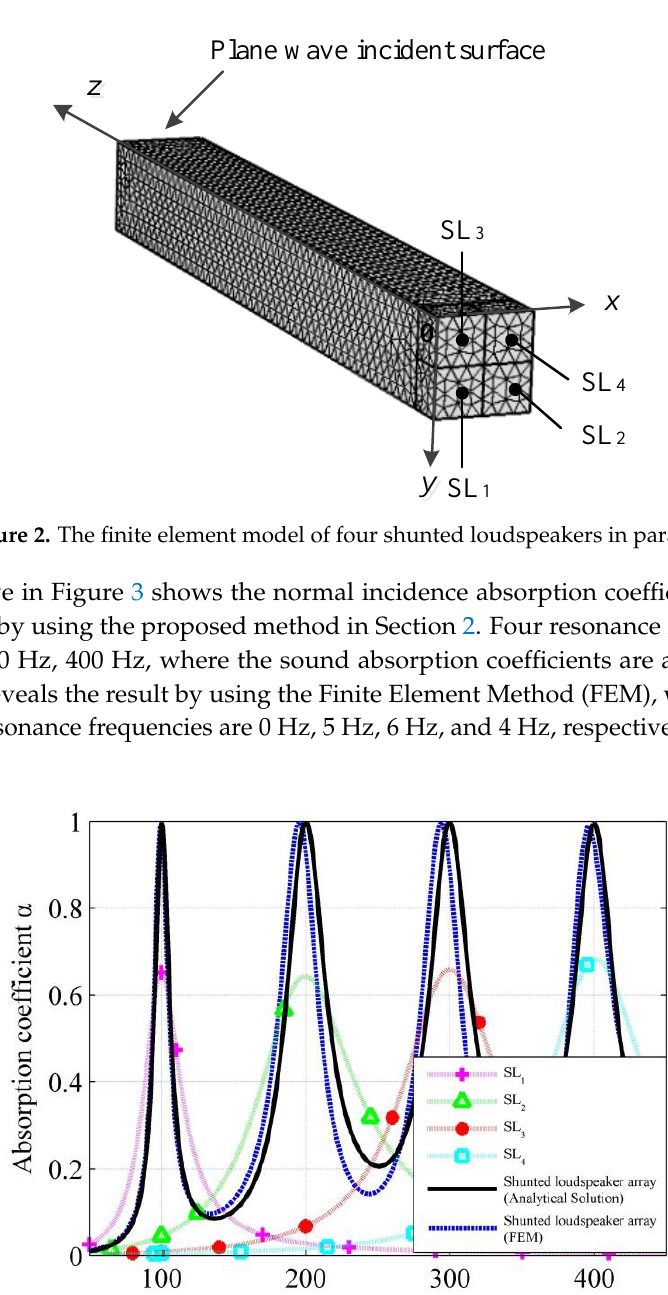
Figure 3. The normal incidence sound absorption coefficients by analytical solution and the finite element model method: SL 1 unit (magenta dotted line marked with plus sign), SL 2 unit (green dotted line marked with upward-pointing triangle), SL 3 unit (red dotted line marked with solid circle), SL 4 unit (cyanine dotted line marked with blank circle), shunted loudspeaker array by analytical solution (black solid line), shunted loudspeaker array by FEM (blue dashed line).